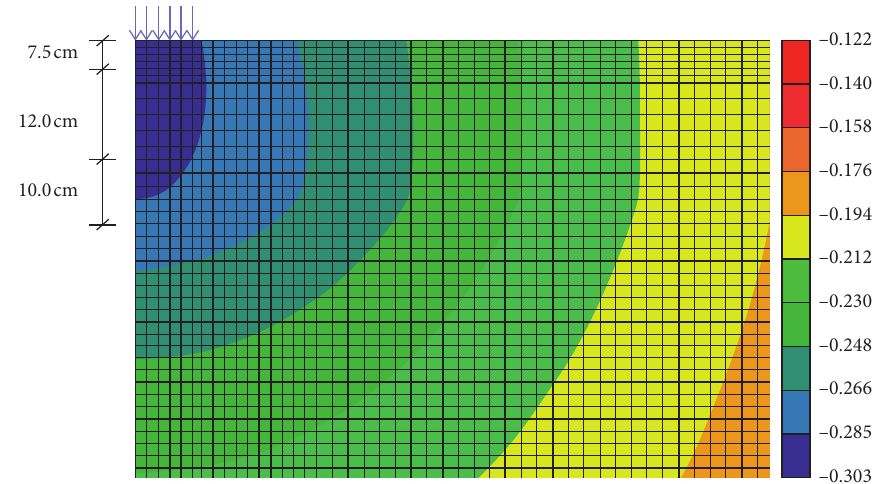
Figure 8: Deflection at the top of the